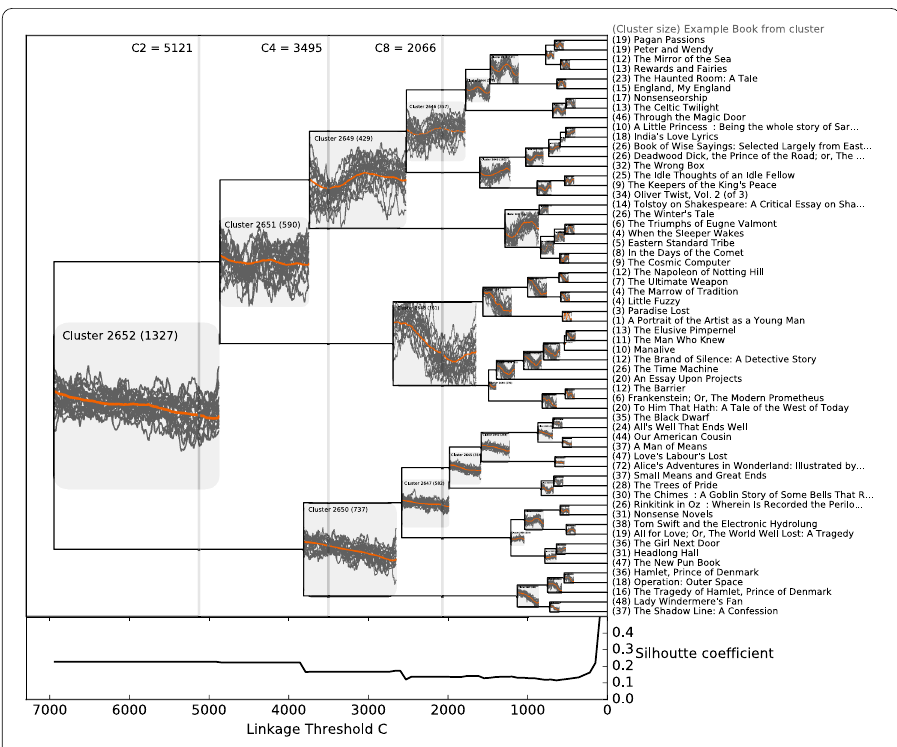
Figure 5 Dendrogram from the hierarchical clustering procedure using Ward’s minimum variance method. For each cluster, a selection of the 20 most central books to a fully-connected network of books are shown along with the average of the emotional arc for all books in the cluster, along with the cluster ID and number of books in each cluster (shown in parenthesis). The cluster ID is given by numbering the clusters in order of linkage starting at 0, with each individual book representing a cluster of size 1 such that the final cluster (all books) has the ID 2( N – 1) for the N = 1,327 books. At the bottom, we show the average Silhouette value for all books, with higher value representing a more appropriate number of clusters. For each of the 60 leaf nodes (right side) we show the number of books within the cluster and the most central book to that cluster’s book